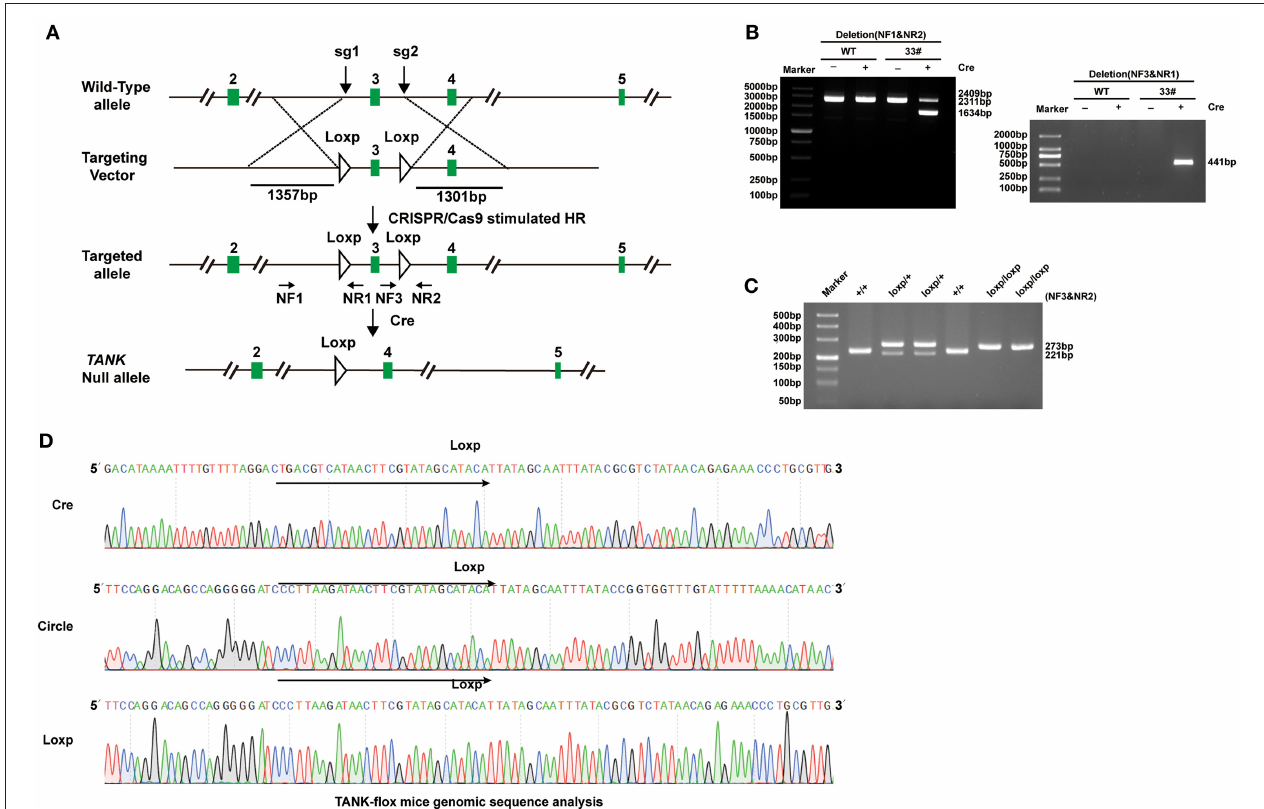
FIGURE 3 | Establishment of TANK-CKO mice. (A) Schematic diagram of the construction of cardiac-specific TANK knockout mice. (B) PCR and 3% gel electrophoresis were used to identify the recombinant TANK-gene Floxed site in founder mice mediated by Cre-loxP. Genomic DNA from founder mouse (33#) was processed using Cre recombinant enzyme and used as a template. NF1 & NR2 primers and NF3 & NR1 primers are respectively used for amplification and then gel electrophoresis was performed. A smaller band appeared in the NF1 & NR2 amplification (1634 bp), NF3&NR1, which originally extended in the opposite direction, amplified a bright band. Among all bands, 2409bp band was loxP Founder mouse genome, 2311bp band was WT mouse genome, and 441bp band was cyclization PCR product. (C) PCR and 3% gel electrophoresis were used to identify TANK-flox alleles, in which the single 273bp band represented homozygous insertion of